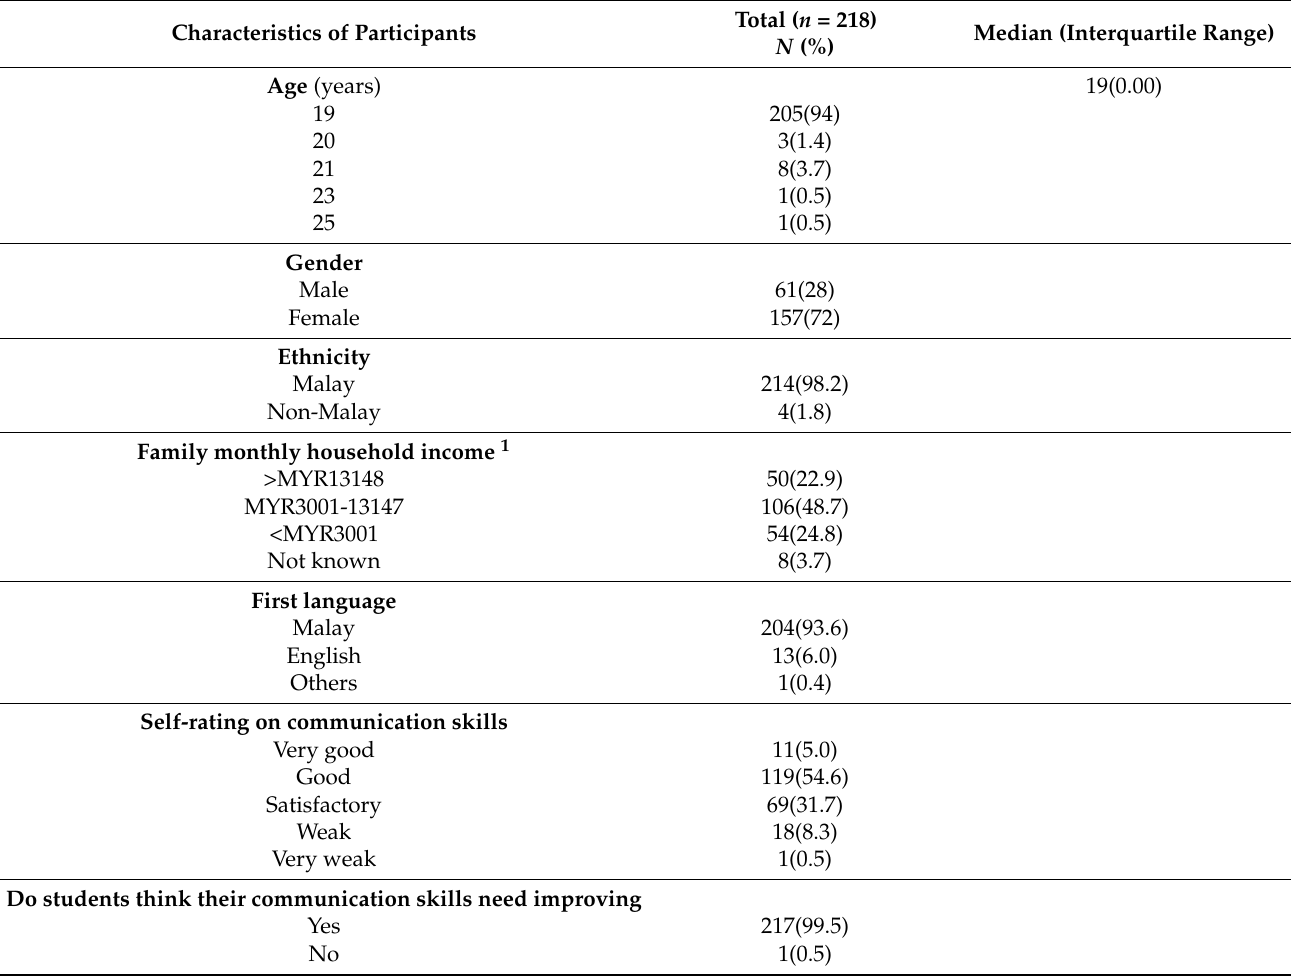
Table 1. Demographic details of